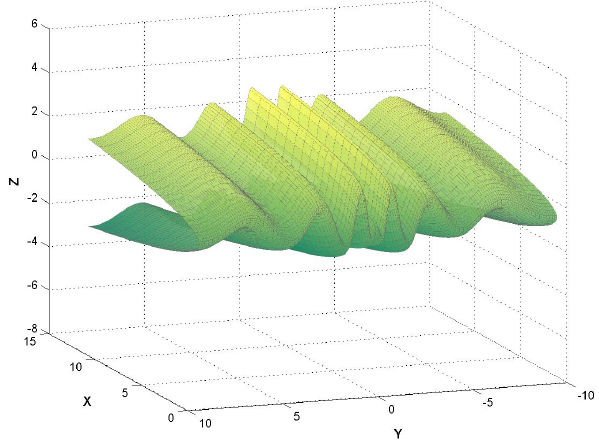
Fig. 10. The “kink”-like disturbances of the current sheet produced by the fixed source.